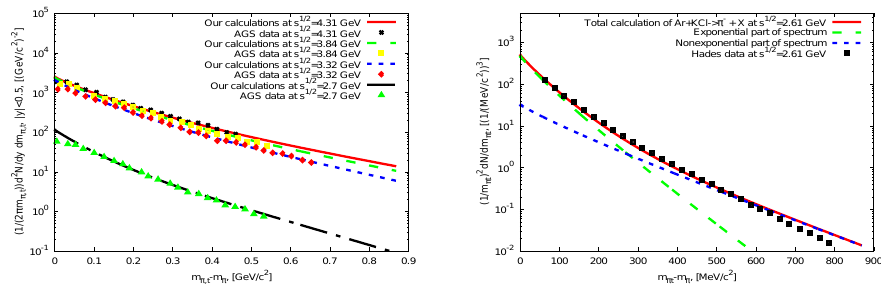
Figure 4. Left: our calculations of pion m π t -spectra in AuAu collision in the mid-rapidity region at √ s = 4.31, 3.84, 3.32,2.7 GeV or the initial kinetic energies per nucleon about E kin = 8,6,4,2 GeV respectively. They are compared to the AGS data [30]. Right: results of our calculations of pion m π t - √ s = 2.61 GeV or at initial kinetic energy spectra in ArKcl collision in the mid-rapidity region at per nucleon about 1.75 GeV compared to the HADES data [31]; the long dash line corresponds to the exponential part of pion spectrum given by Eq. (13) and the short dash curve corresponds to the nonexponential part given by Eq.